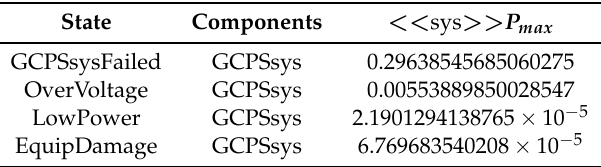
Table 2. Verification results for a GCPS